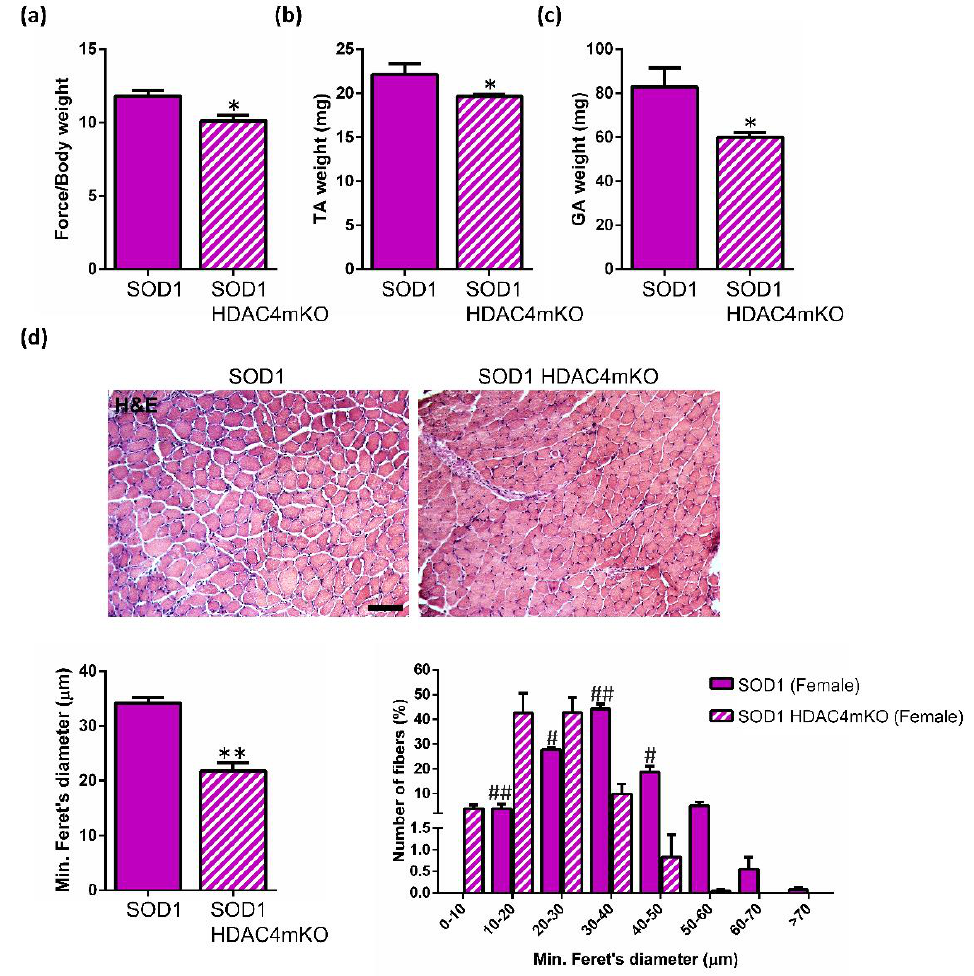
Figure 4. Deletion of HDAC4 worsens muscle atrophy in female SOD1 mice. ( a ) Muscle performance of SOD1 and SOD1 HDAC4mKO mice by grip test, at 18 weeks of age. Data are expressed as the mean of developed force over the mouse weight, +/ − SEM. n = 4 mice for genotype; * p < 0.05 by Student’s t -test. ( b ) TA muscle weight of SOD1 and SOD1 HDAC4mKO mice at 18 weeks of age. Data are expressed as mean +/ − SEM. n = 5 SOD1 and n = 7 SOD1 HDAC4mKO mice; * p < 0.05 by Student’s t -test. ( c ) GA muscle weight of SOD1 and SOD1 HDAC4mKO mice at 18 weeks of age. Data are expressed as mean +/ − SEM. n = 3 mice for each genotype; * p < 0.05 by Student’s t -test. ( d ) Representative images of TA muscle histology of female SOD1 and SOD1 HDAC4mKO littermates, at 18 weeks of age. Scale bar = 100 μm. Minimum Feret’s diameter of SOD1 and SOD1 HDAC4mKO TA myofibers at 18 weeks of age. Data are expressed as mean +/ − SEM. Myofiber minimum Feret’s diameter distribution. Data are expressed as mean +/− SEM. n = 3 mice for each genotype; ** p < 0.005, # <0.001, ## <0.0001 by Student’s t -test.